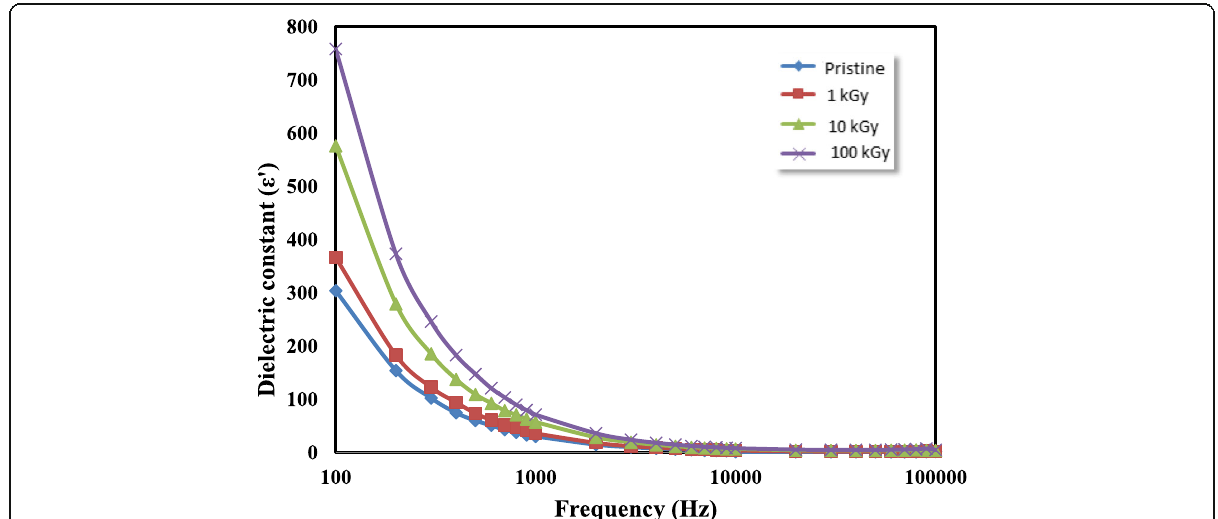
Fig. 2 Frequency dependence of the dielectric constant for the investigated samples at room